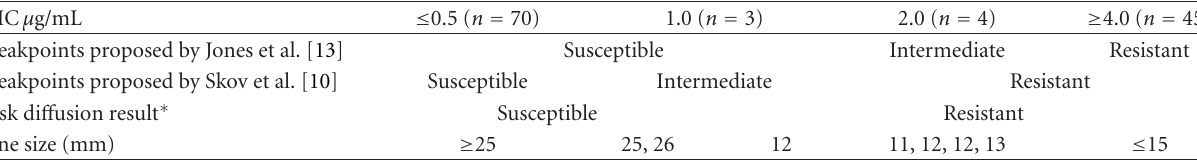
Table 2: Comparison of disk di ff usion and proposed MIC interpretive criteria for S. aureus and fusidic acid.